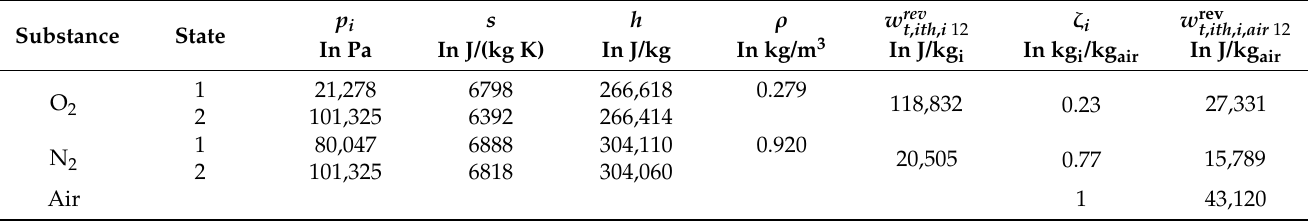
Table 1. Property values and results of the rev. isothermal partial compression for oxygen generation at 293.15 K (Database: